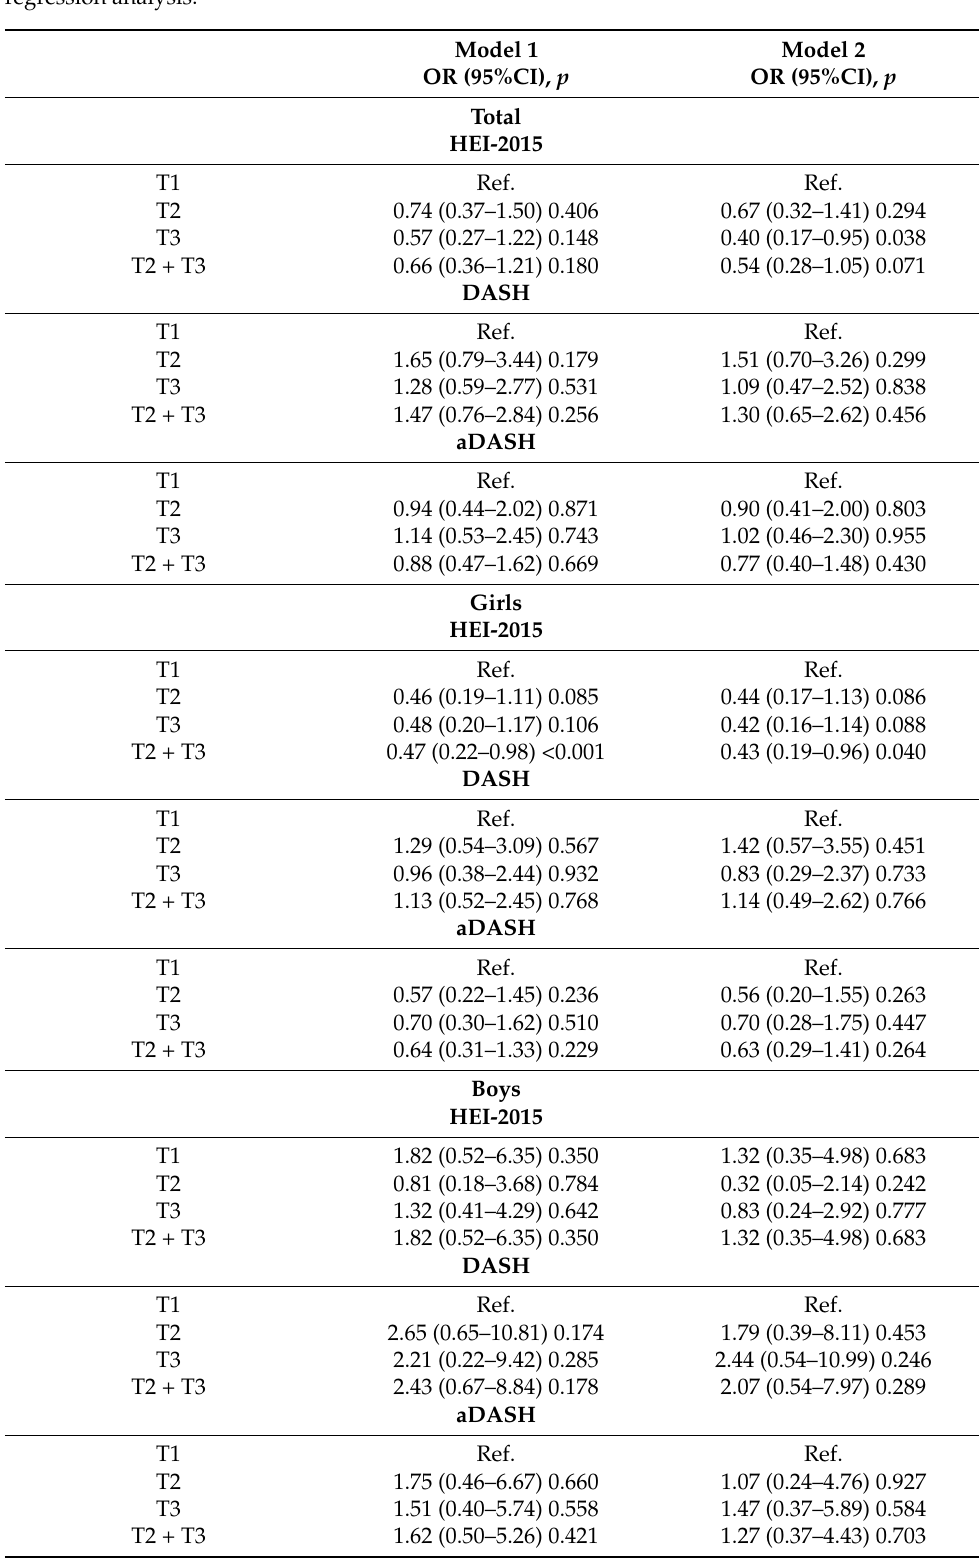
Model 1. Crude model. Model 2. Adjusted for age, sex, z-score of BMI, and activity coefficient. HEI-2015. Healthy eating index; DASH. Dietary Approaches to Stop Hypertension; aDASH. Alternate Dietary Approaches to Stop Hypertension, p -values < 0.05 were considered statistically